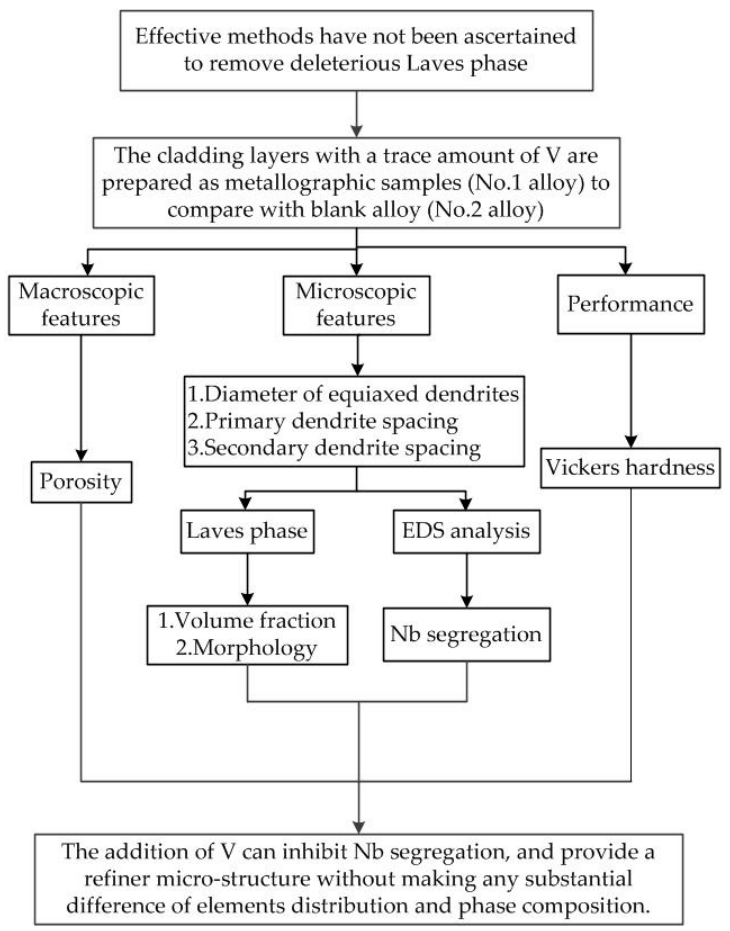
Figure 2. The workflow in this study.